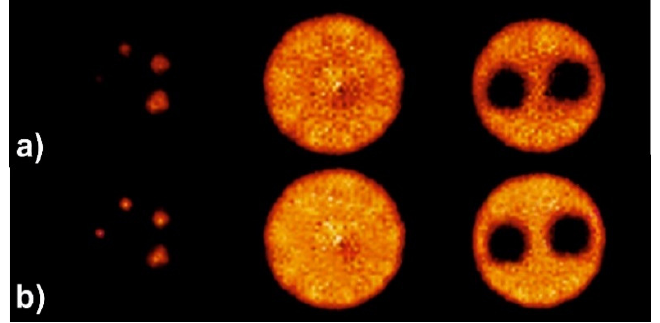
Figure 6. Representative slices through the image quality phantom produced for a PET scanner using: ( a ) Anger positioning logic and ( b ) MLP algorithm.